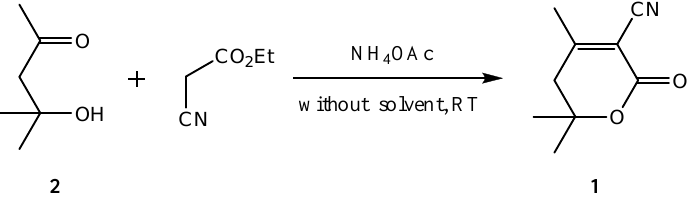
Figure 1. Synthesis of 4,6,6-trimethyl-2-oxo-5,6-dihydro-2H-pyran-3-carbonitrile 1